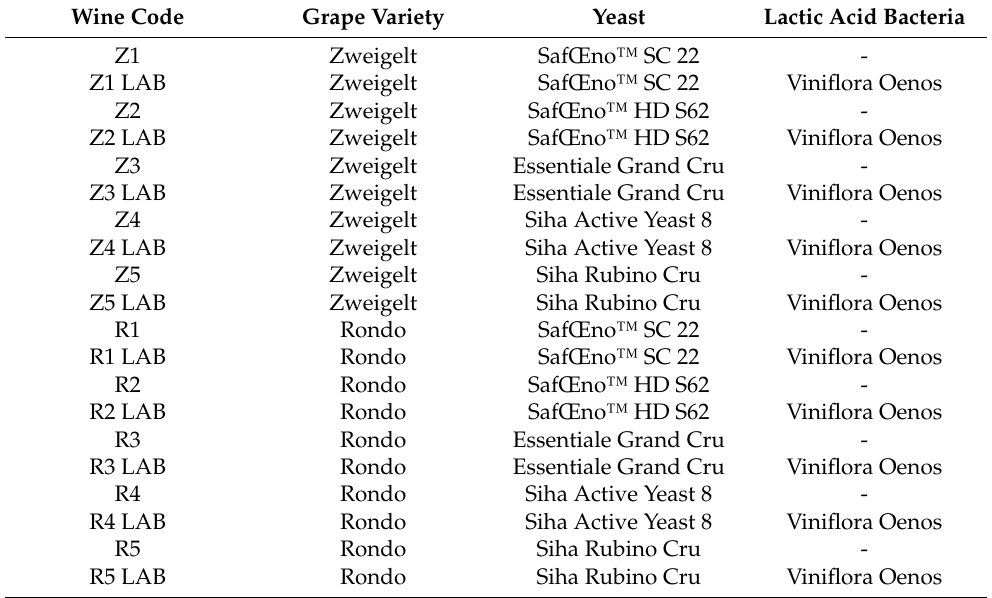
Table 5. Description of wine